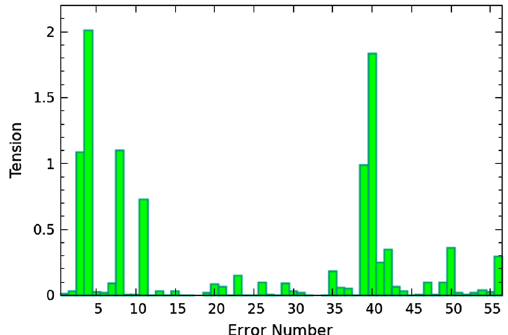
Fig. 2 The tension between shifts for the ATLAS 8 TeV lepton + jet data, between the individual distributions. This is calculated as (cid:7) (cid:7) 4 4 ( 1 / 6 ) (λ − λ ) where λ i , j i , l i , j is the i th nuisance param- j = 1 l > j eter calculated when fitting the j th distribution